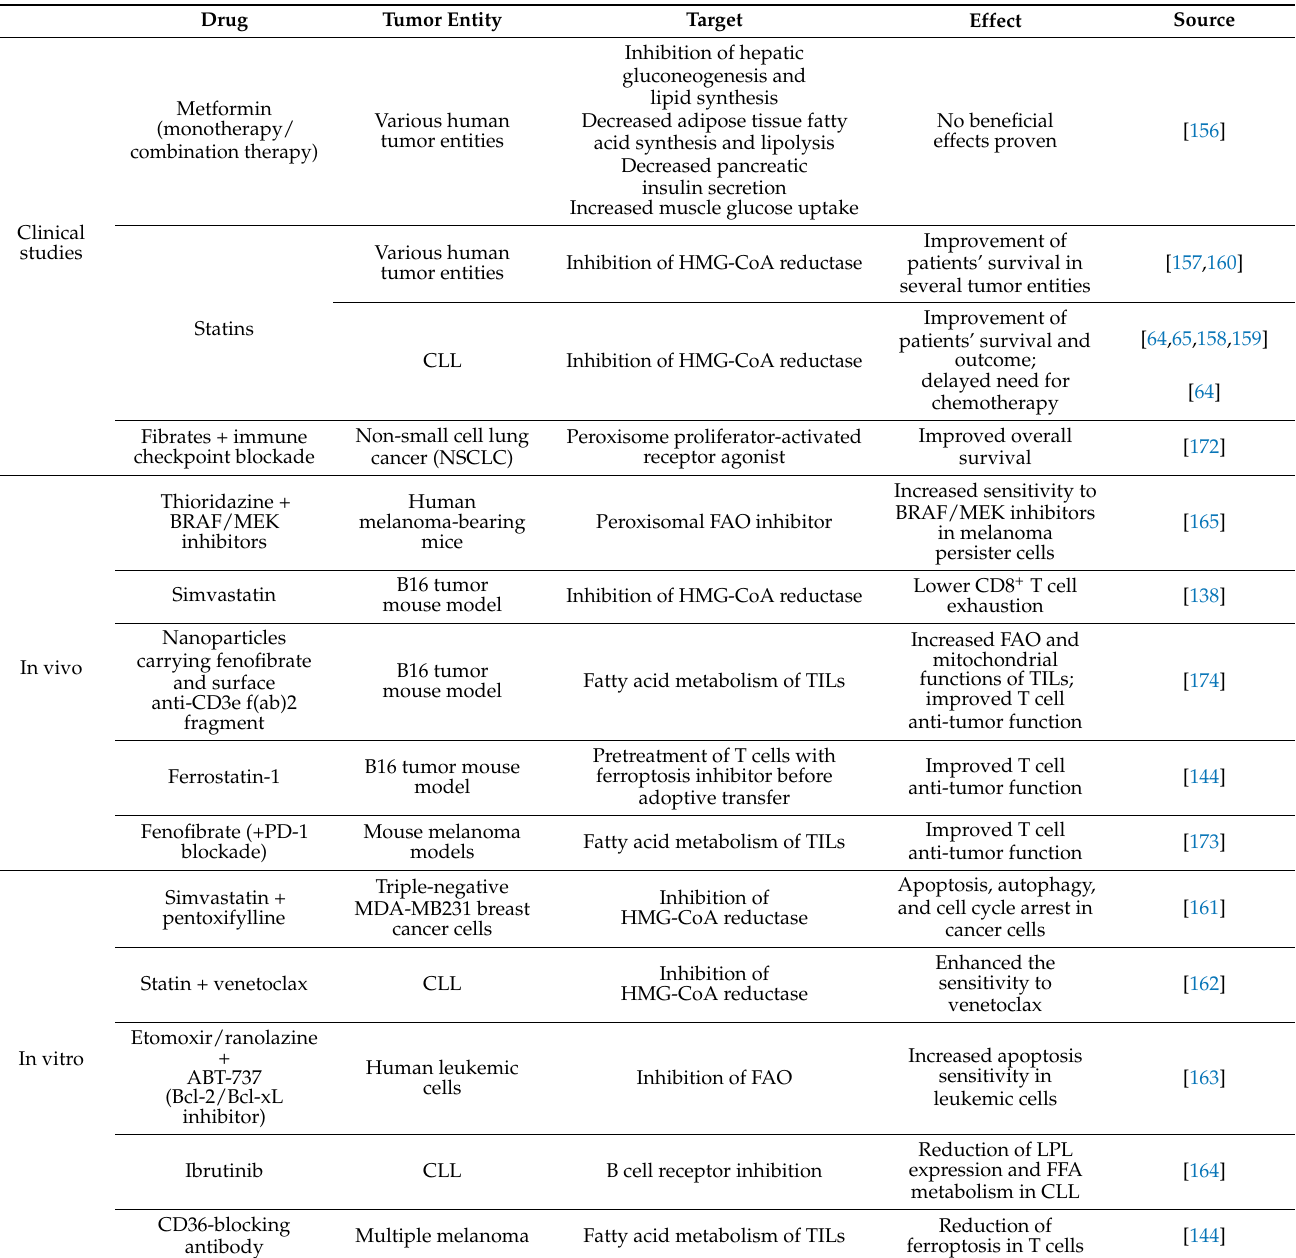
Table 1. Selected examples of intervention in fatty acid metabolism for cancer